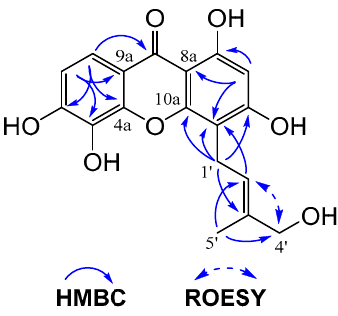
Figure 1. Key HMBC and ROESY correlations of hypxanthone A.